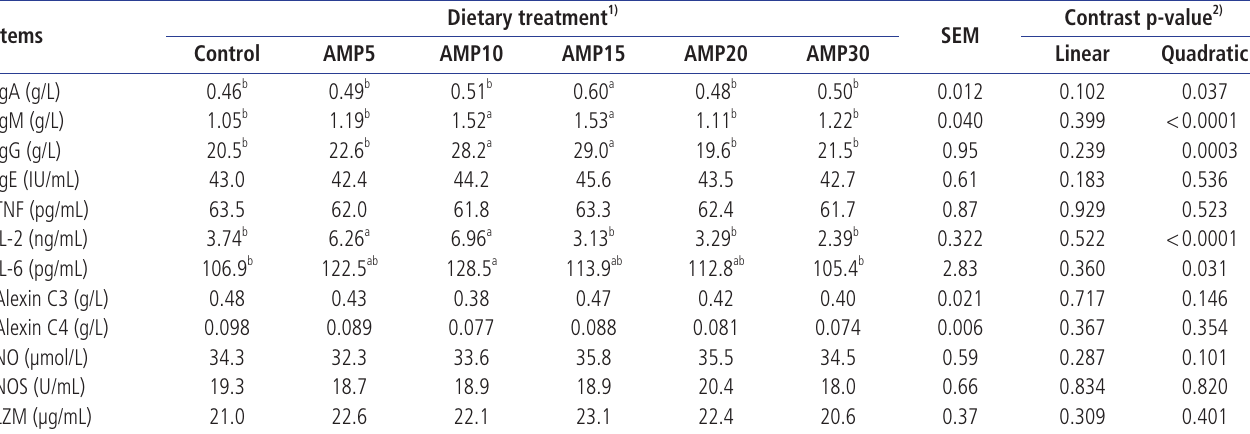
Dietary treatment